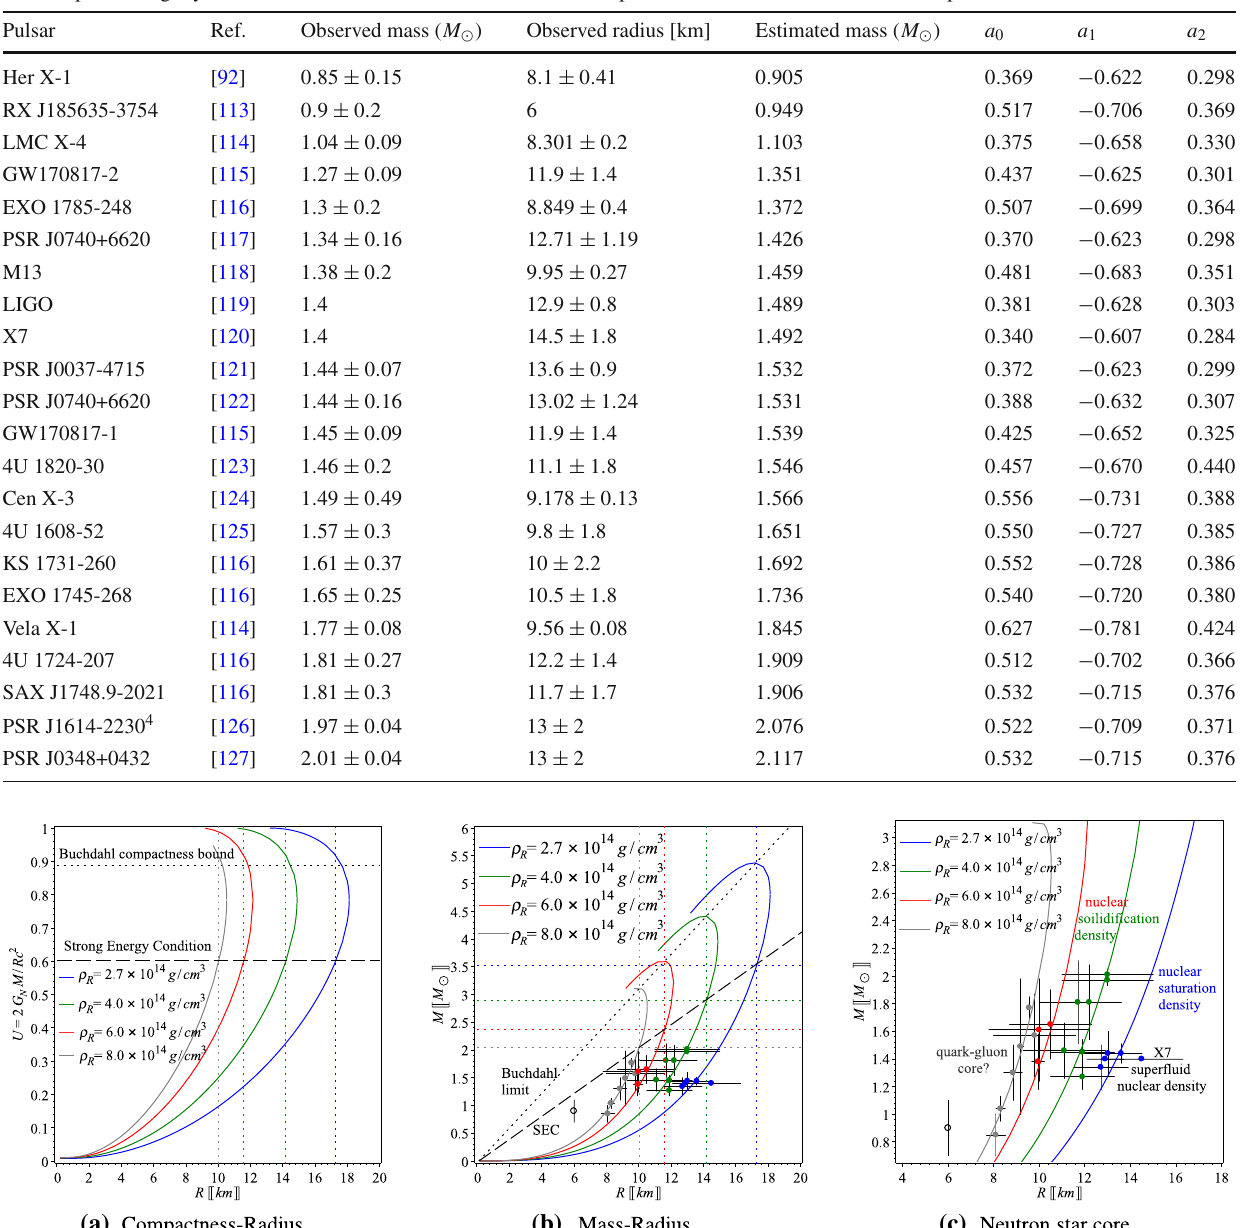
Fig. 9 a Compactness-radius profiles for four surface densities, the horizontal dot and dash lines visualize Buchdahl ( U = 8 / 9) and the SEC bound ( U ((cid:2) = − 0 . 1 ) = 0 . 603) on the compactness parameter. Clearly both constraints give almost the same maximum radii. b Mass- radius profiles for four surface densities combined with observed mass- radius values of the pulsars in Table 1. The diagonal dot and dash lines set Buchdahl and SEC physical regions. Clearly all pulsars are below